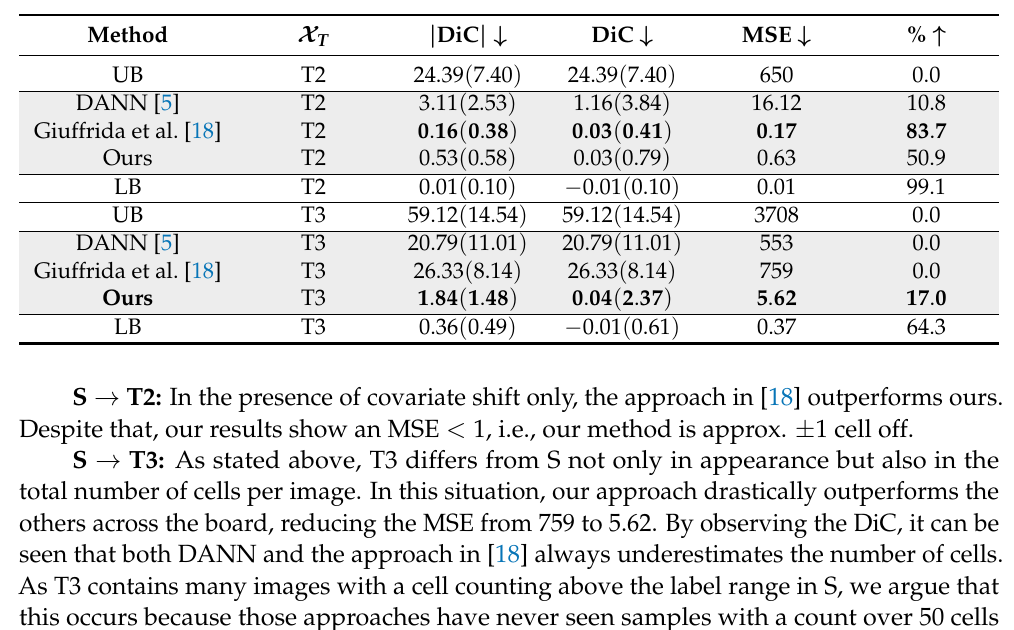
Table 2. Cell counting domain adaptation results for S → T2 and S → T3 experiments. Together with the DA results, we also report the upper bound (UB)—testing on the target dataset without the adversarial adaptation step—and the lower bound —supervised learning on the target dataset. Main results are highlighted in grey. For DiC and | DiC | we report mean ( std ).